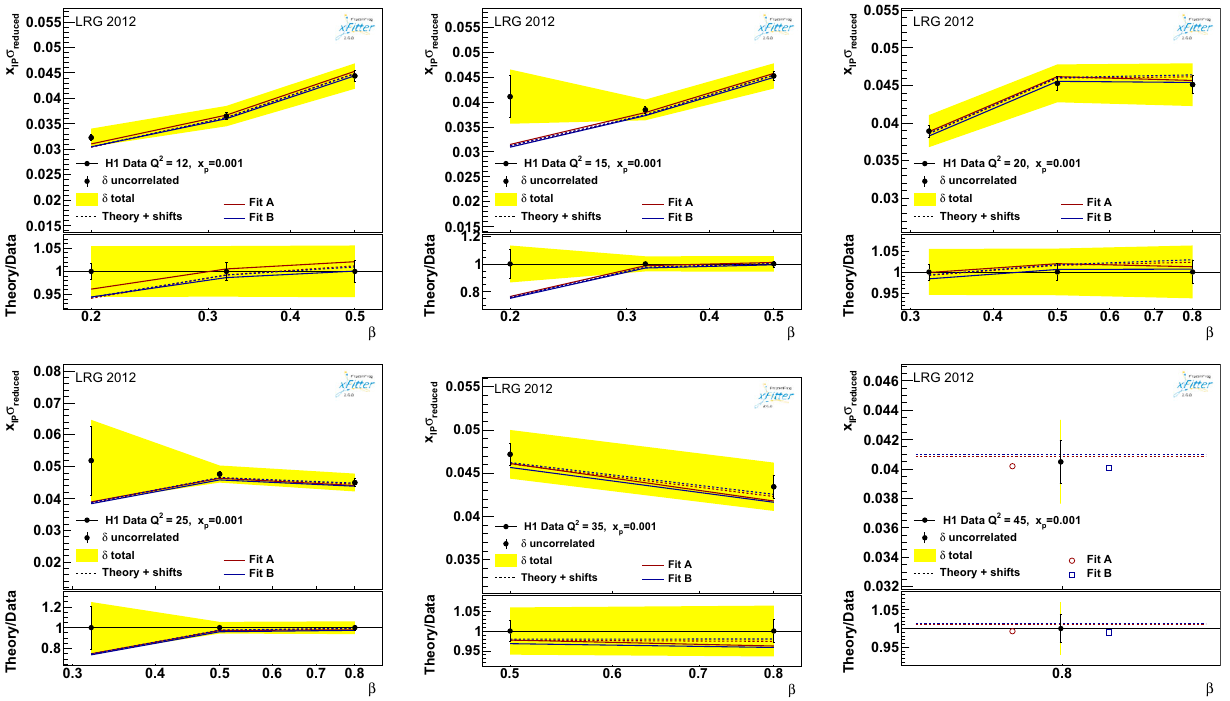
Fig. 8 The results of our NLO pQCD fit based on Fit B for the reduced diffractive cross section x IP σ D x IP = 0 . 001 in comparison with H1-LRG-2012 data [44]. The error